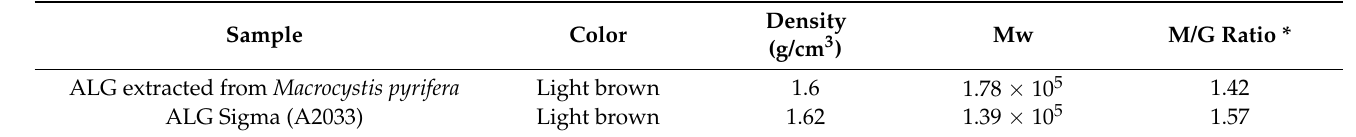
Table 1. Physicochemical properties of ALG extracted from Macrocystis pyrifera and commercial ALG